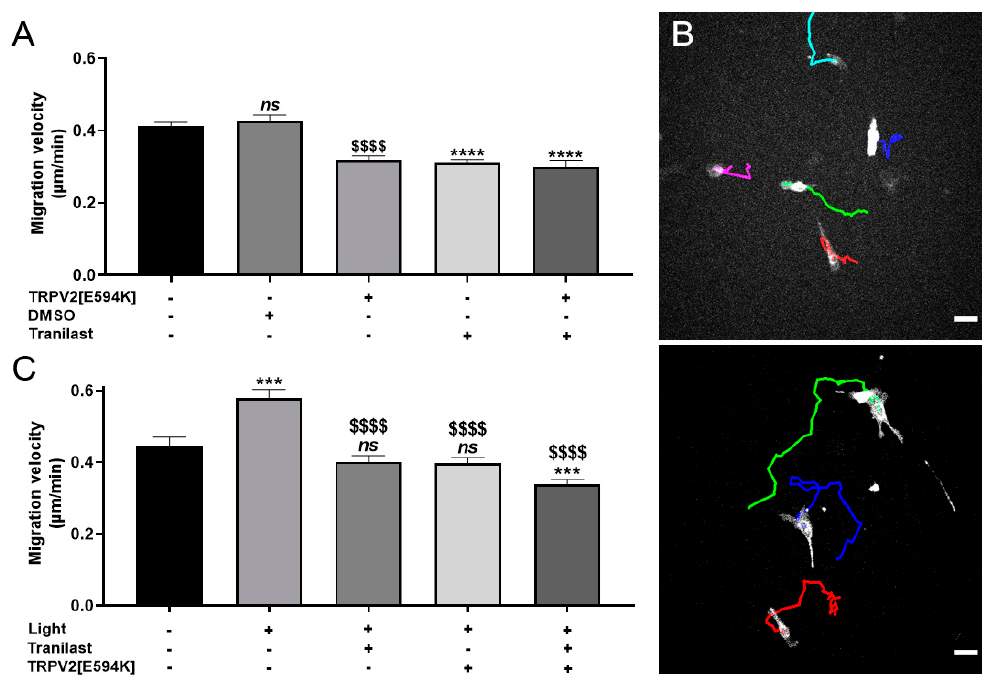
Figure 5. Light stimulation promotes cell migration mediated by TRPV2 in C2C12 myoblasts expressing eNpHR. ( A ) The role of TRPV2 channels in cell migration was evaluated with a cell migration tracking assay on C2C12 myoblasts expressing eNpHR. Cells were seeded at low density and the migration velocity ( µ m / min) was assessed for 15 h with a JuliStage system. C2C12 myoblast migration was evaluated for five conditions: without treatment ( n = 432), co-transfected with TRPV2[E594K] ( n = 290), treated with DMSO 1 / 1000 ( n = 180), treated with 100 µ M Tranilast ( n = 285), and co-transfected with TRPV2[E594K] plus treated with 100 µ M Tranilast ( n = 89) ($ corresponds to the comparison with C2C12 myoblasts without treatment, * corresponds to the comparison with C2C12 myoblasts treated with DMSO 1 / 1000) ($$$$ and ****: p < 0.0001, Mann–Whitney test). ( B ) Cell trajectories of eNpHR-YFP-expressing C2C12 myoblasts (white cells) that were unstimulated (upper panel) or stimulated (lower panel) by light. Scale bar: 60 µ m. ( C ) E ff ect of light stimulation on cell migration investigated by cell migration assay on C2C12 myoblasts expressing eNpHR-YFP. Cells were seeded at low density and the migration velocity ( µ m / min) was assessed for 15 h on C2C12 myoblasts in five conditions: unstimulated (n = 115) or stimulated with light without treatment ( n = 125), treated with 100 µ M Tranilast (n = 133), co-transfected with TRPV2[E594K] ( n = 162), or co-transfected with TRPV2[E594K] and treated with 100 µ M Tranilast (n = 163). $ corresponds to the comparison with C2C12 myoblasts stimulated by light, * and ns corresponds to the comparison with unstimulated C2C12 myoblasts. Data are shown as mean ± SEM (***: p < 0.001; $$$$: p < 0.0001, Mann–Whitney test). Light-stimulated C2C12 myoblasts migrated faster compared to unstimulated cells (Figure 5B). Indeed, whereas control cells migrated at a velocity of 0.446 ± 0.023 µ m / min ( n =